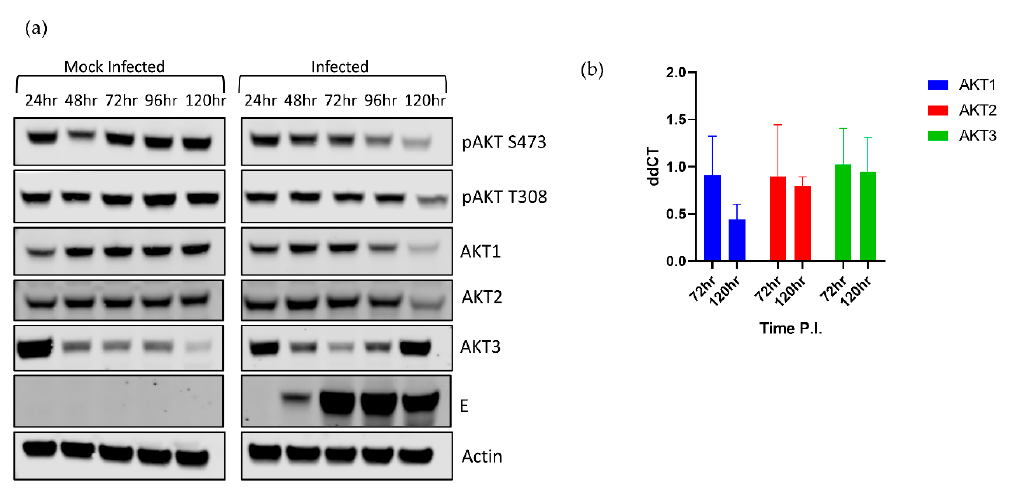
Figure 1. Langat virus (LGTV) causes differential expression levels of the AKT isoforms. 293T cells were infected with LGTV at a multiplicity of infection (MOI) of 0.1 and harvested at the indicated timepoints. ( a ) Representative Western blots showing AKT isoform levels as well as phosphorylation patterns. ( b ) mRNA analysis of AKT isoforms in infected and mock infected cells. AKT isoform mRNA was evaluated compared at 72 and 120 hpi. The observed differences were not statistically significant.